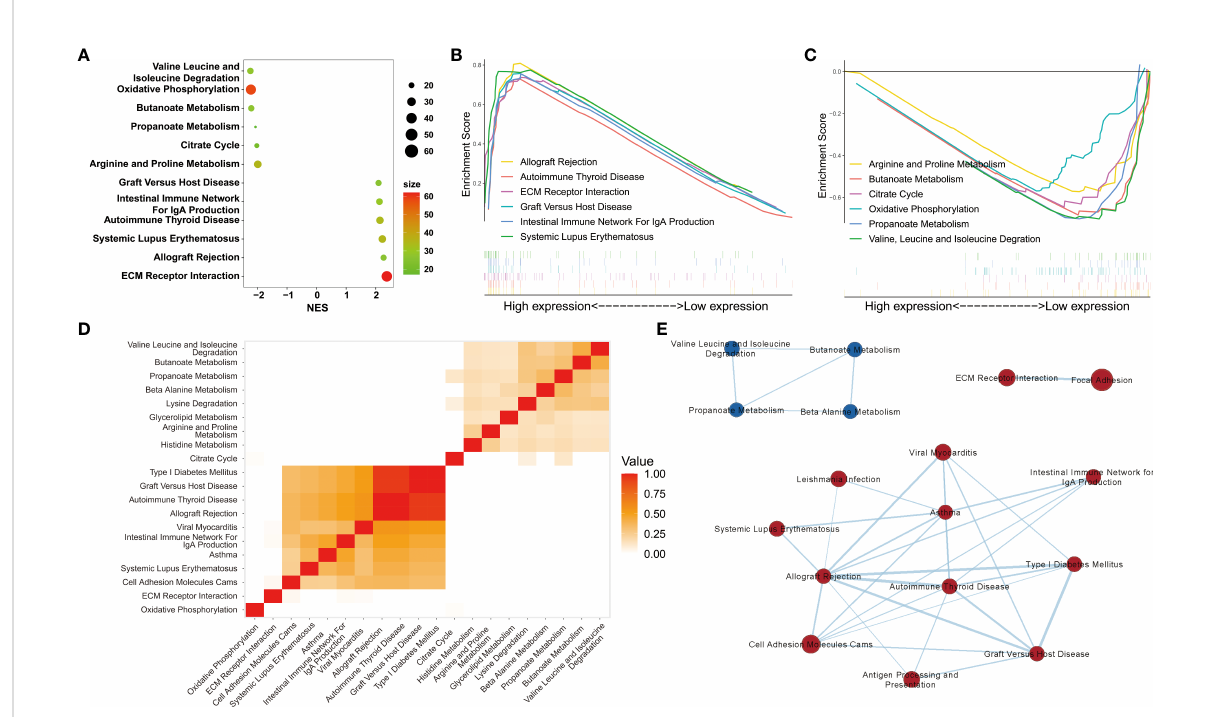
FIGURE 3 Gene set enrichment analyses. (A) The six pathways with the highest normalized enrichment scores (NES) in DN and control groups. (B, C) Visualization of the six pathways with the highest NES in the DN and control groups. (D) Heatmap and (E) enrichment of the results of leading edge